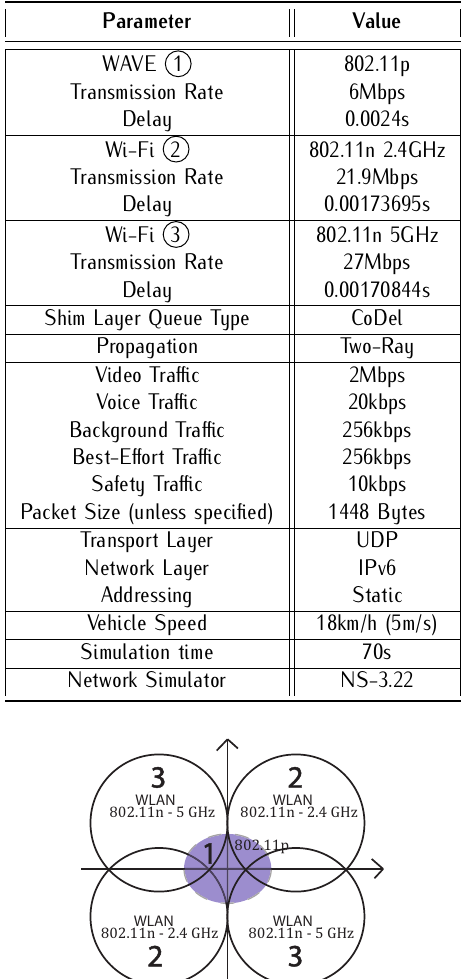
Table 1. NS-3 Simulation Setup